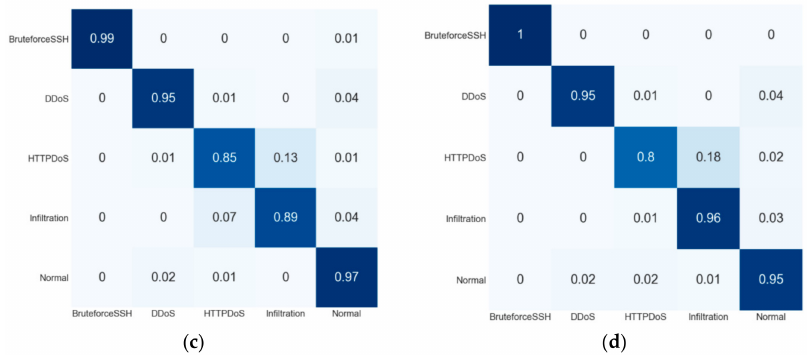
Figure 6. Confusion matrix of the ISCX-IDS 2012 dataset: ( a ) proposed process flow, ( b ) standard process flow, ( c ) SFS-DT-based feature selection, and ( d ) SBS-DT-based feature selection.